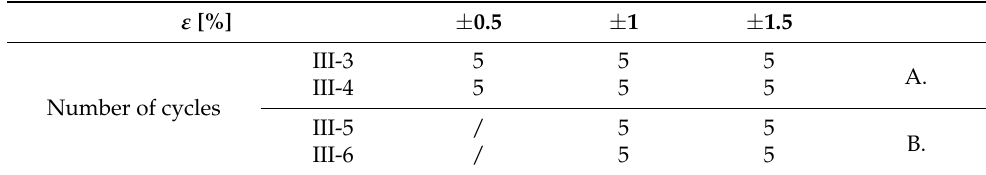
Table 1. Sample testing